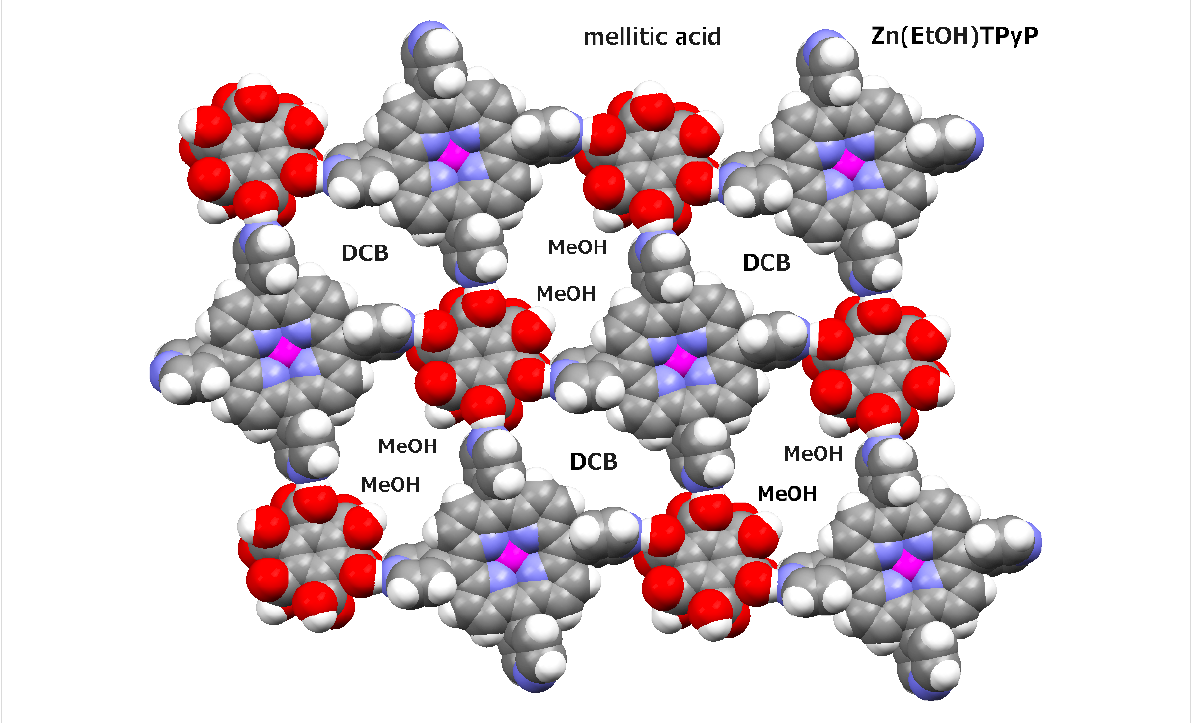
Figure 2: Space-filling representation of the hydrogen-bonded heteromolecular network in II . Note that every porphyrin unit is in direct hydrogen- bonding contact through its pyridyl groups with four molecules of mellitic acid and vice versa. Two of the carboxylic groups of the latter point into the intralayer voids. They are solvated in the crystal by molecules of the methanol solvent (MeOH) that occupy the adjacent voids, the alternating voids being occupied by the o -dichlorobenzene (DCB) solvent. These flat layers are aligned parallel to the (110) plane of the crystal. In this figure, at every porphyrin site the EtOH axial ligand is connected to the central zinc ion from below, preventing self-coordination of the ZnTPyP units (as in I